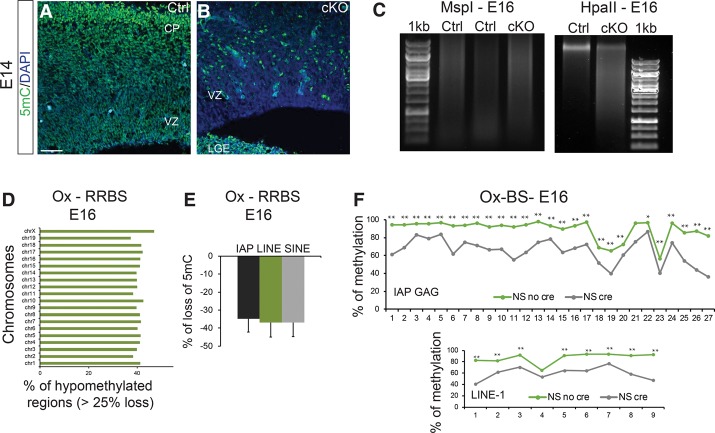
Changes in DNA methylation in Uhrf1 cKO cerebral cortices. (A,B) Confocal images of coronal sections of E14 control (A) and cKO (B) cerebral cortices stained for 5mC and DAPI. (B) Note that 5mC is much reduced in the cKO cortex but not LGE. (C) Restriction digests of E16 genomic DNA from controls and Uhrf1 cKO digested with HpaII and MspI and analyzed on a 0.5% agarose gel. (1 kb) One-kilobase DNA ladder. Note that both enzymes recognize the CCGG sequence; however, HpaII is unable to cut DNA when the internal cytosine is methylated. As much more DNA was cut in the Uhrf1 cKO samples, this indicates less DNA methylation upon Uhrf1 deletion. (D,E) Ox-RRBS in E16 control and cKO cortices, with graphs depicting the percentage of regions hypomethylated (X-axis) per chromosome (Y-axis) (D) and the percentage of hypomethylation in each repeat element class (E). Error bars indicate standard error of mean between the values from each independent element from each class. (F) Ox-BS in E16 control and cKO cortices showing a loss of 5mC in Uhrf1 cKO cortices. High-throughput sequencing was performed on the IAP Gag region and L1. The plot displays 27 CpGs present on IAP Gag loci, nine CpGs present on L1 loci, and their methylation status. The Y-axis indicates the percentage of methylation, and the X-axis indicates individual CpGs. (*) P-value ≤ 0.001; (**) P-value < 0.0001.